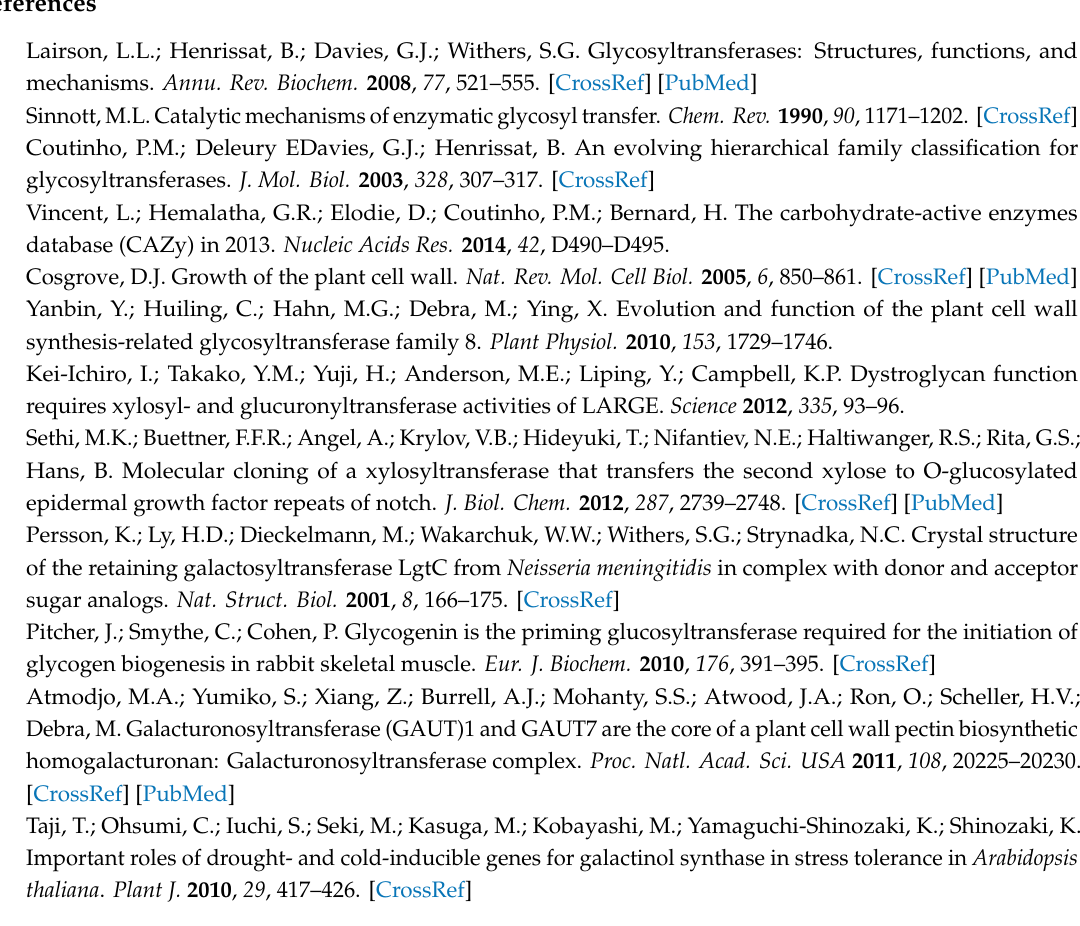
divergence times of duplicate gene pairs. Table S13: Transmembrane helical domains (TMHs) and subcellular localizations of GT8 proteins in O. sativa ssp. japonica . Table S14: statistical results of rice GT8 gene cis-element containing the information of Figure S4. Table S15: Pearson’s correlation coe ffi cients of duplicate gene pairs. Figure S1: A high-resolution version of Figure 1. Figure S2: A high-resolution version of Figure 3. Figure S3: The phylogenetic tree (A), conserved motif compositions (B), and exon / intron structure (C) of the GT8 genes in these seven species. A. A UPGMA phylogeny tree of GT8 protein sequences from H. vulgare , B. distachyon, O. sativa ssp. japonica , O. rufipogon , S. italica , S. bicolor , and Z. mays . Di ff erent colors of branches represent di ff erent subfamilies. The di ff erent species are indicated by di ff erent shaped markers. B,C. The relative lengths of genes and proteins were showed by the widths of the grey bars. The exons and introns were displayed by yellow boxes and grey lines, respectively. Figure S4: Cis-acting elements in all GT8 genes of Oryza sativa ssp. japonica . A. The primary categories and secondary categories were shown by di ff erent bars and di ff erent characters. The di ff erent colors in histograms mean the number of di ff erent promoter elements in each secondary category. B. The di ff erent subfamilies of GT8 genes in the phylogenetic tree are shown by di ff erent colors and the di ff erently colored boxes represent the di ff erent secondary categories. C. The ratios of primary / secondary categories are displayed by di ff erent sizes in pie charts. Figure S5: Co-expression values of all OsGT8 genes in all tissues (A), under cold stress (B), and under salt